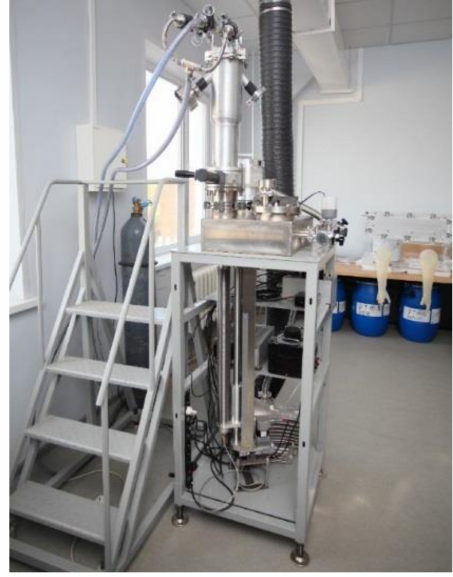
Figure 2. Photo of the lithium deposition